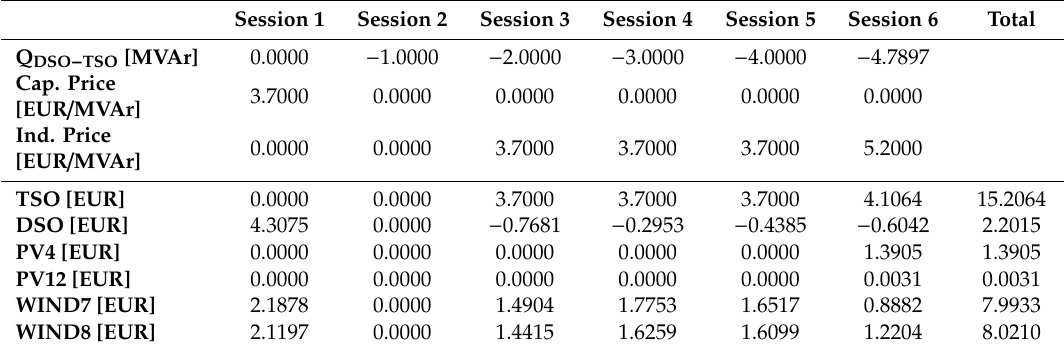
Table 3. Incomes and payments for increasing TSO inductive needs at each market